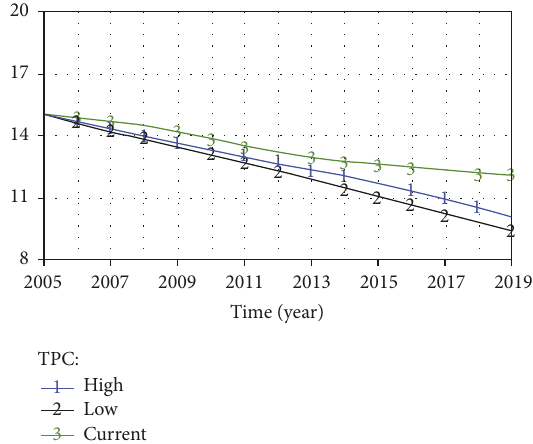
Figure 15: Influences of various trusts on amount of transactional psychological contract implemented